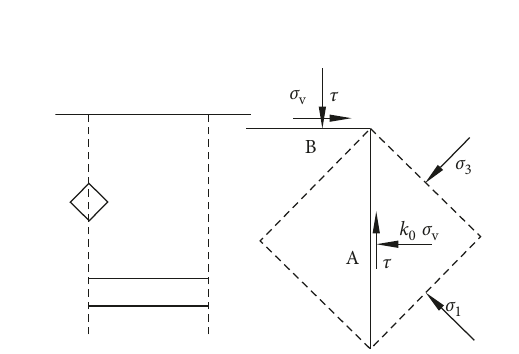
Figure 3: The sliding surface under the state of limit equilibrium.